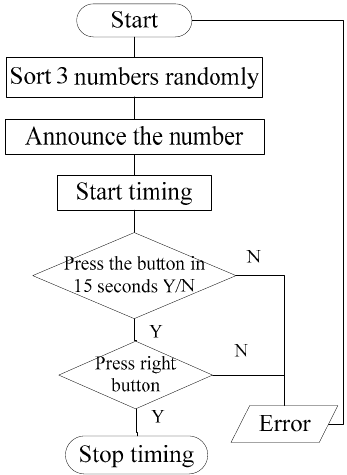
Figure 1. The flow chart of the reaction time test.